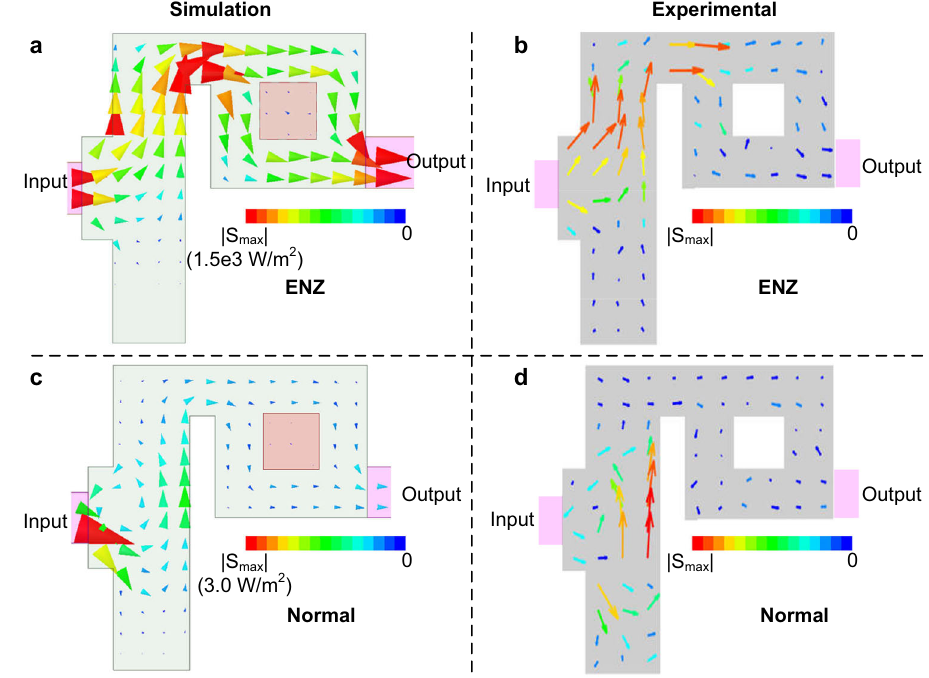
experimentally reconstructed power fl ow of the normal medium with the same dielectric particle but the operating frequency at 3.9GHz.